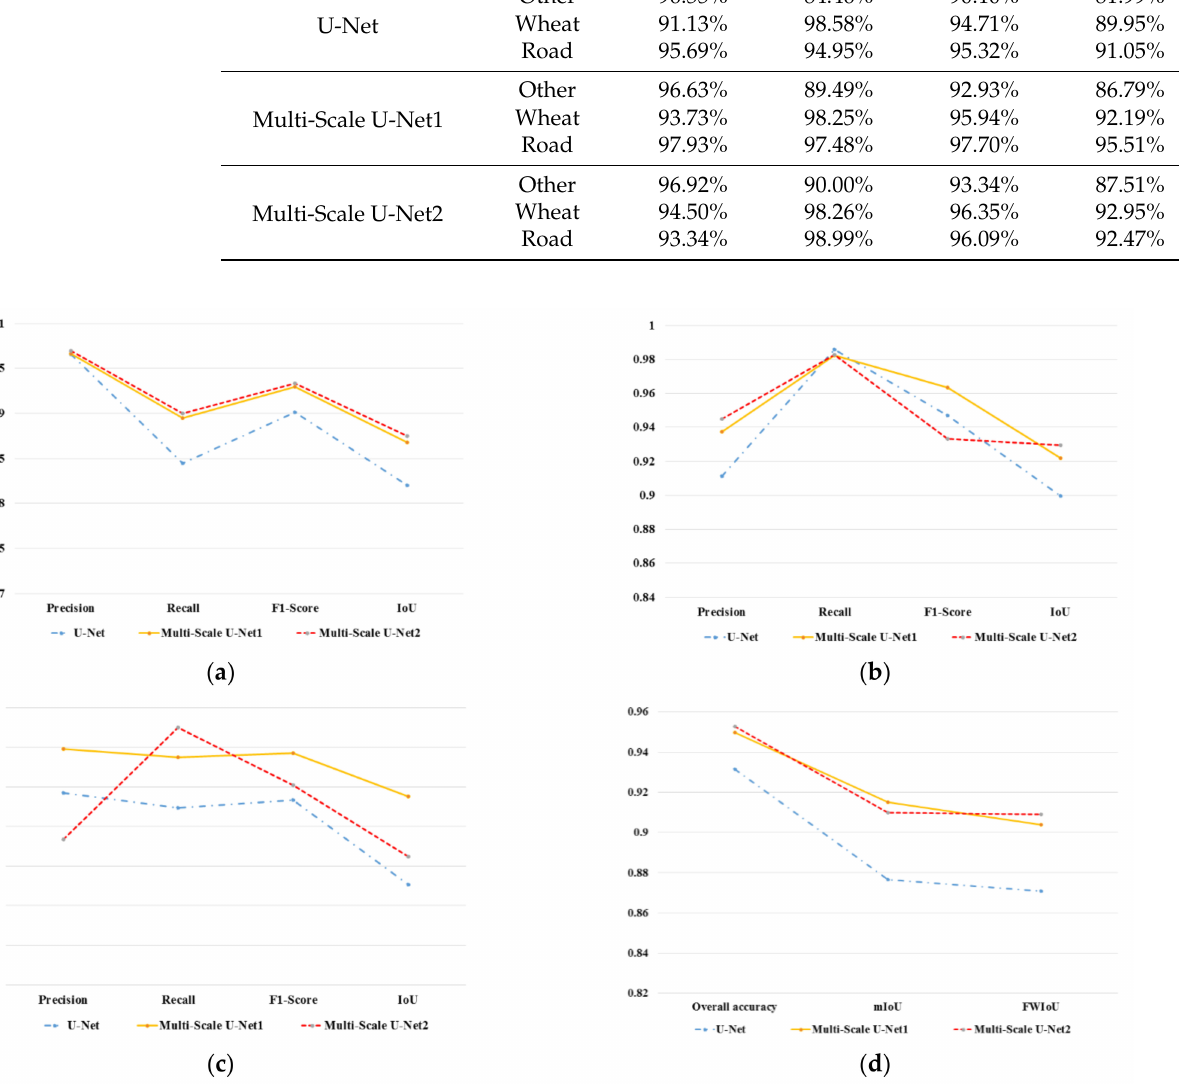
Figure 16. Accuracy evaluation curve. ( a ) Other, ( b ) Wheat, ( c ) Road, ( d ) Overall